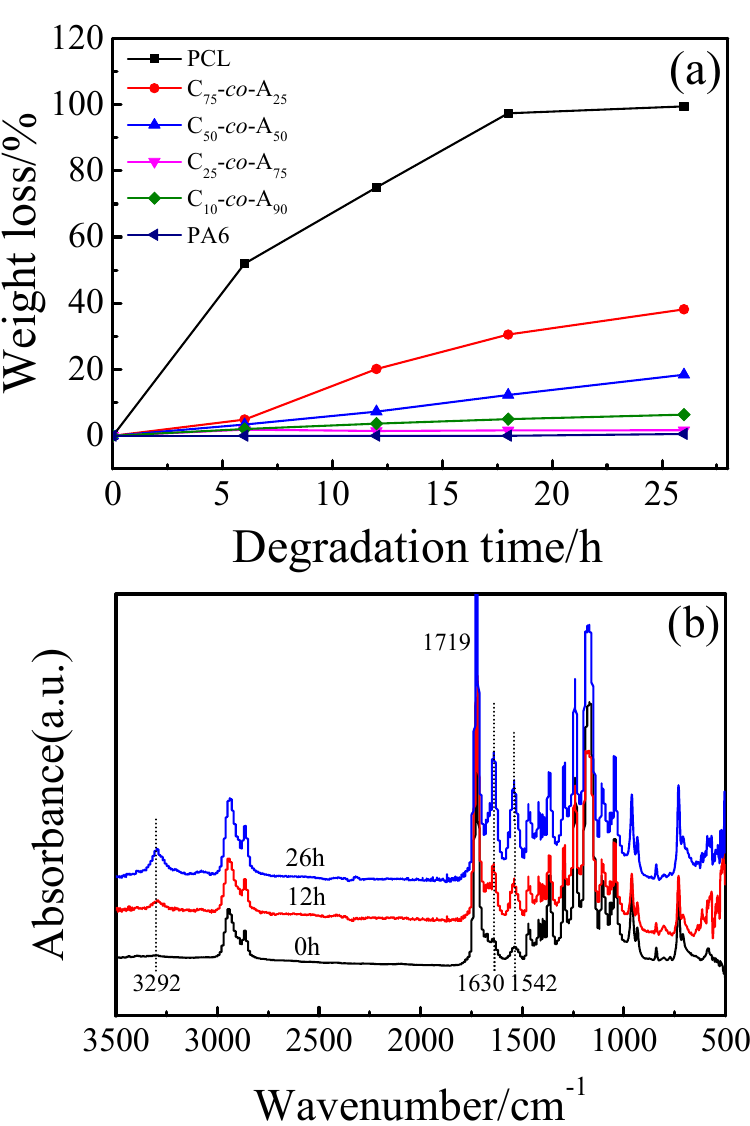
Figure 8. ( a ) Weight loss of PA6 and P(CLA-co-CLO) copolymers in the course of enzymatic degradation, and ( b ) normalized FTIR spectra of C 75 - co -A 25 after degradation for different time.